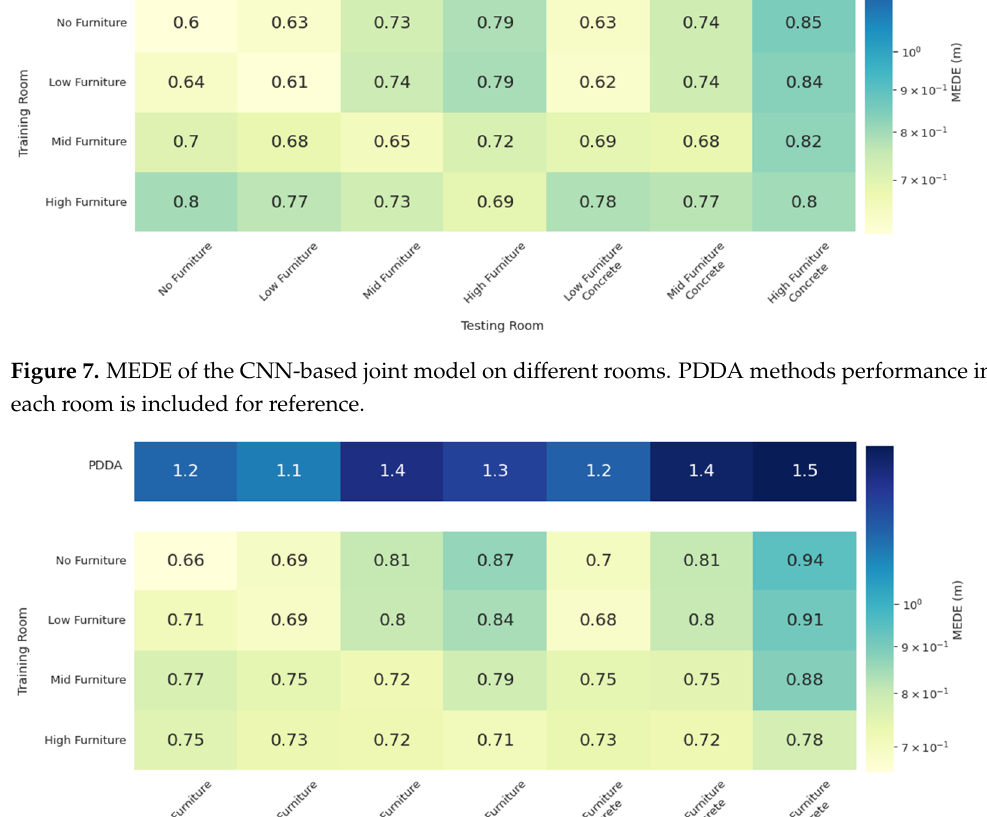
Figure 8. MEDE of the pairs of APs model on different rooms. PDDA methods performance in each